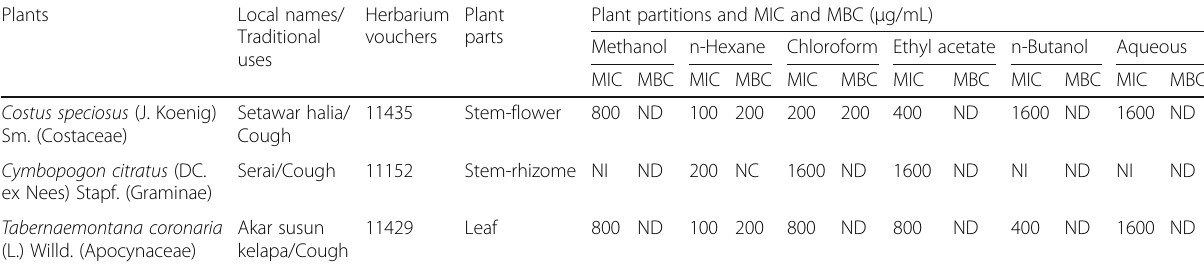
Table 1 Minimum inhibitory concentration and minimum bactericidal concentration values of the plant solvent partitions against Mycobacterium tuberculosis H37Rv